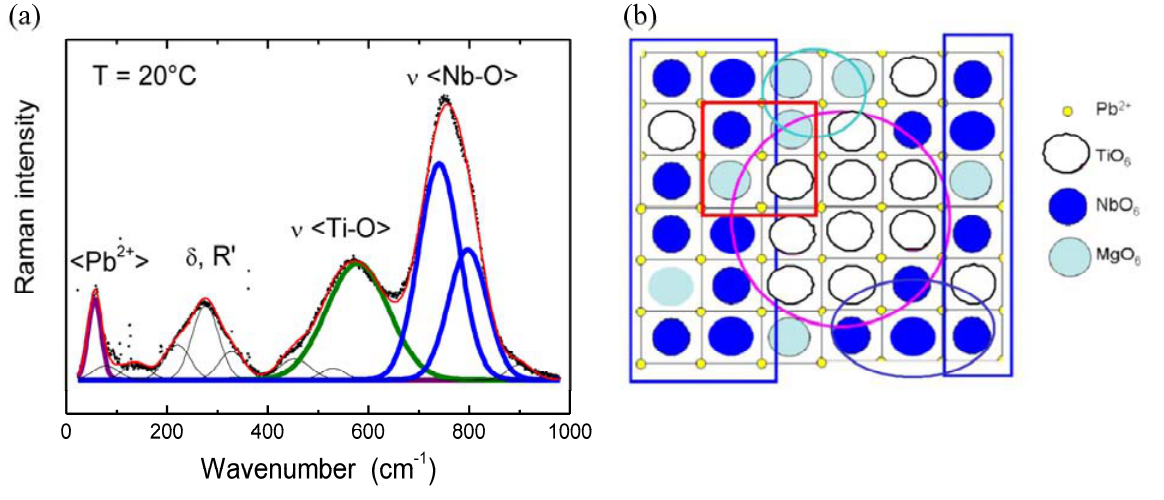
Figure 5. ( a ) Example of Raman spectrum decomposition and mode assignment according to the used sublattice model:  stretching BO modes,  bending modes, R’ librations and 6 <Pb 2+ > translations of Pb 2+ ; ( b ) Sketch of the very local distribution of the different BO 6 octahedra: at least four domain types are present: Ti-based, Mg-based, Nb-based and region(s) at the boundary between “pure”